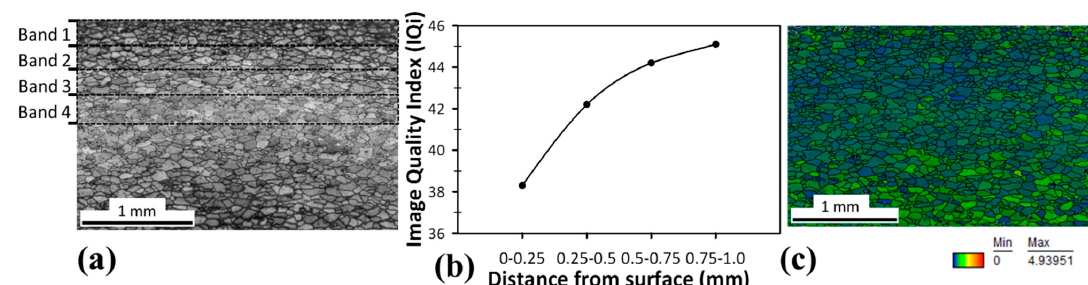
Figure 2. Microstructural characteristics of the hot-rolled material: ( a ) IQ contrast map, ( b ) variation of the IQ index from the surface to mid-thickness and ( c ) grain average misorientation (GAM) map.